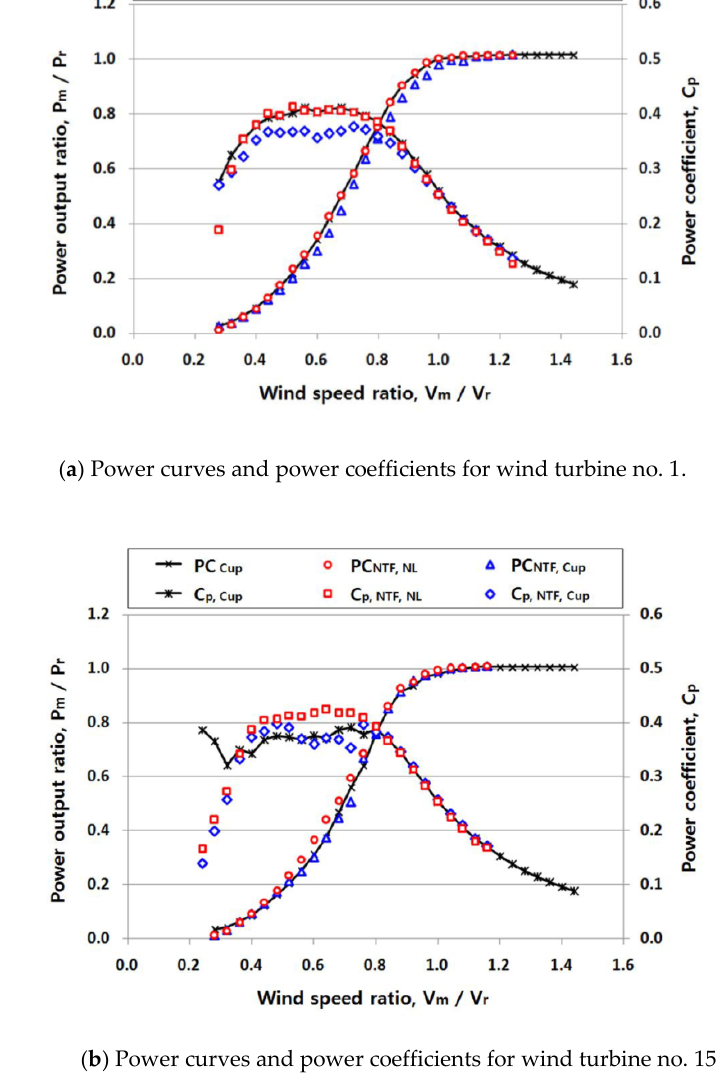
Figure 4. Comparison of power curves and power coefficients.